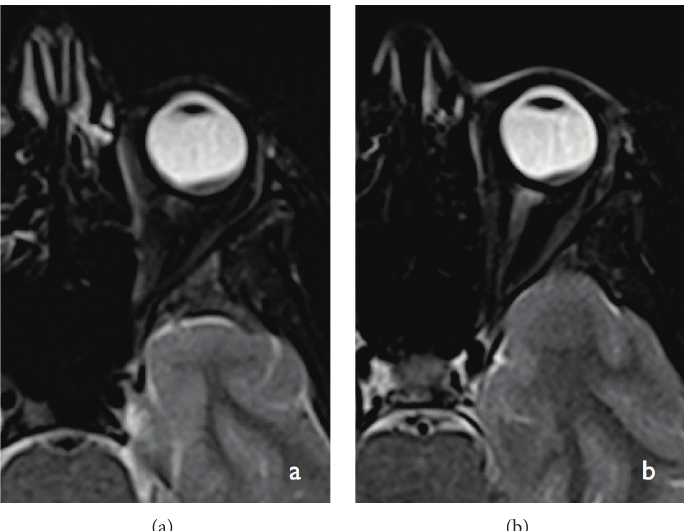
Figure 5: Axial T2-FLAIR MRI image showing that the lesion appears hypointense to gray matter with typical signal intensities of the optic nerve.